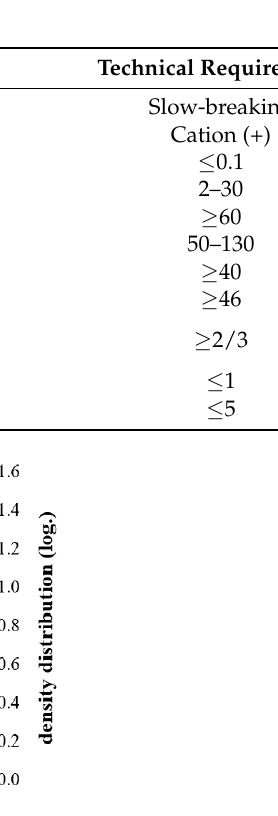
Table 2. The properties of asphalt emulsion.